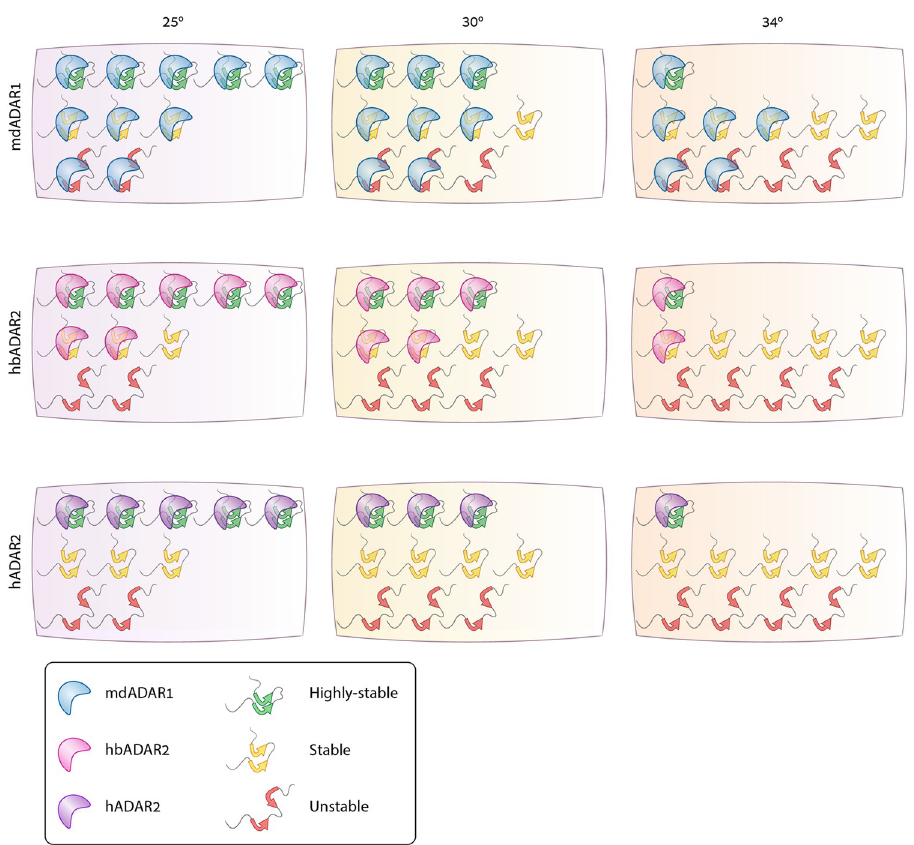
Fig 7. Possible model for the hyper A-to-I editing resulting from the exogenous expression of mdADAR1 in yeast. mdADAR1 and hbADAR2 originated from birds with core temperature of 42˚C and 40˚C, the warm end of the endothermic spectrum, have probably evolved to better recognize partially destabilized dsRNA structures. Their exogenous expression in yeast stimulated the highest association with dsRNA structures and editing activity in all temperatures when compared to hADAR2 evolved at lower body temperature. Temperature increase leads to a shift in the distribution of structures, with less tight ones (green) and more partially destabilized ones (red), which is reflected in the total number of edited sites and a partial growth restoration of growth and viability in cells carrying the hbADAR2, to some extent, and mostly hADAR2.